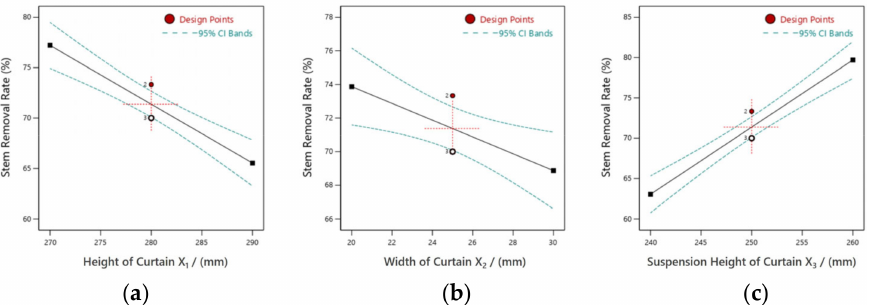
Figure 8. Curve of single factor effect on potato stalk removal rate. ( a ) Effect curve of the height of curtain (X1) on the stem removal rate. ( b ) Effect curve of the width of the curtain on the stem removal rate. ( c ) Effect curve of the hanging height of the curtain on the stem removal rate. The red dots represent the design points. The blue dotted lines represent the 95% confidence interval. The black curve is the effect curve of the single factor on the test